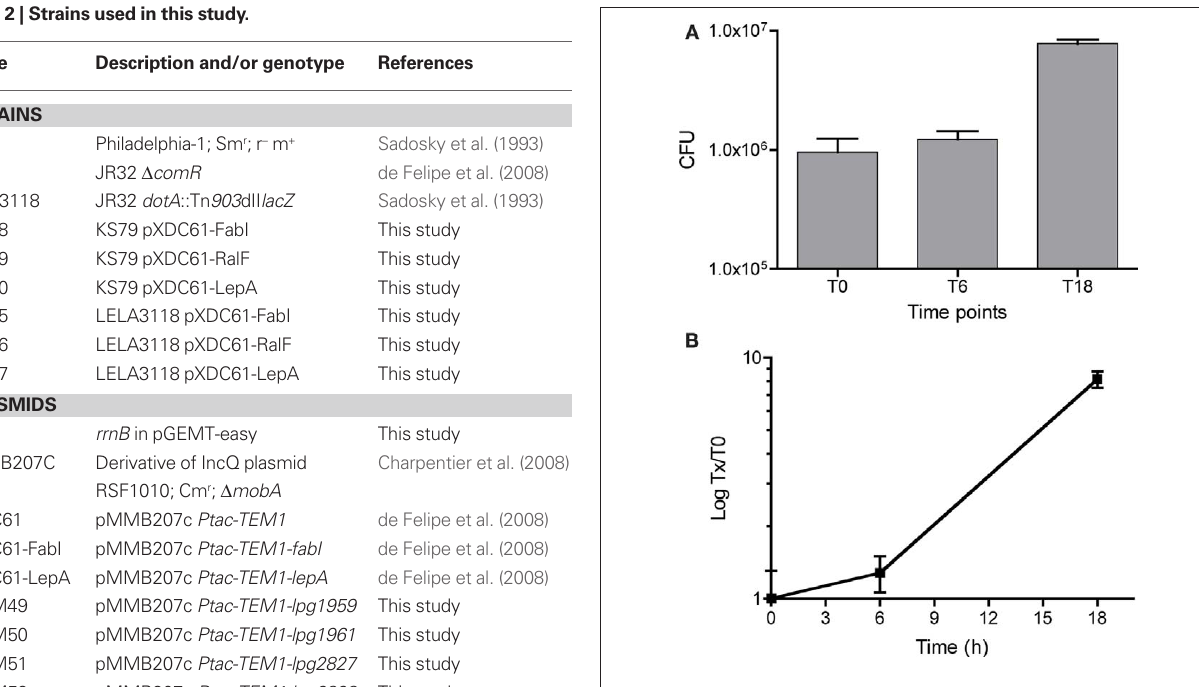
FIgURe 1 | Kinetics of THP-1 macrophage infection by Legionella pneumophila . (a) Ten million human cultured THP-1 macrophages were infected with L. pneumophila at a MOI of 1. At each time point, cells were washed three times and a fraction was resuspended in distilled water to release intracellular bacteria. Shown is the number of colony forming units (CFU) present inside the totality of cells. (B) CFU was normalized against the number of CFU at T0 to show change in